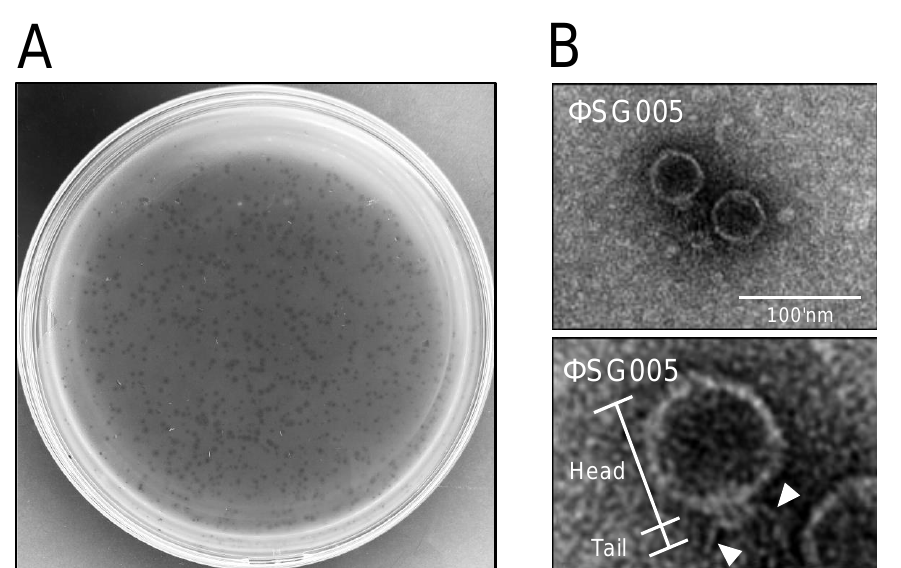
Figure 1. Isolation of a streptococcus virus, Φ SG005. ( A ) Plaques representing phages are observed on a lawn of S. gordonii ATCC10558. ( B ) Electron microscopic image showing phage particles exhibiting Podoviridae characteristics (upper panel). Lower panel indicates representative morphological structures of the viral particle including the head and tail. Arrowheads indicate the long tail fibers of the virus. Bar = 100 nm.